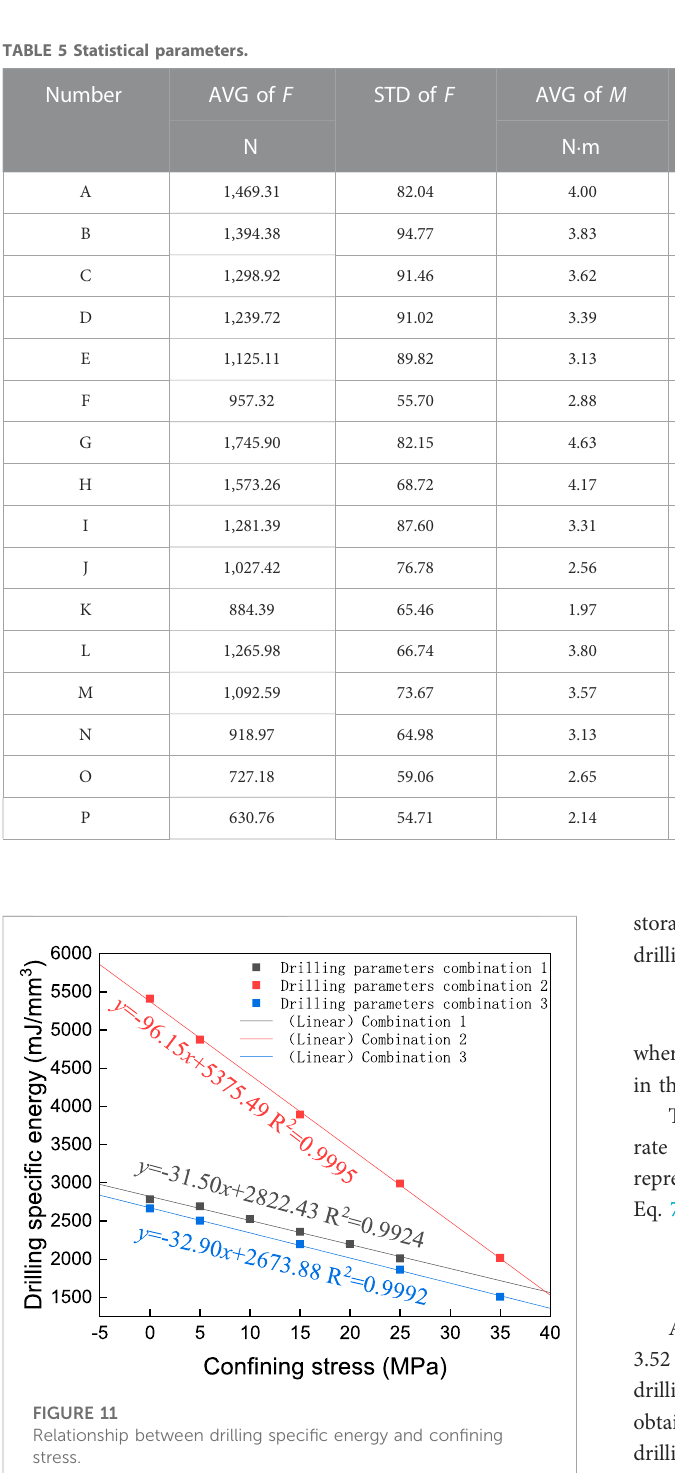
According to Eq. 3, when the con fi ning stress is 35 MPa, u e 3.52 mJ/mm 3 . The relationship between u m and u e drilling tests is shown in Figure 13. By linear fi tting, it can be obtained that δ is 1/381 and u e is about 8.05 mJ/mm 3 under drilling parameter combination 1. Under drilling parameter combination 2, δ is 1/1,179, and u e is about 5.21 mJ/mm 3 . Under drilling parameter combination 3, δ is 1/404, and u e is about 7.27 mJ/mm 3 . Substituting δ into Eq. 7, u e was calculated for each test (Table 8; Figure 14). The value of u e under different con fi ning stresses is approximately constant, which is independent of con fi ning stress. However, the total energy in the rock varies under different drilling parameter combinations.